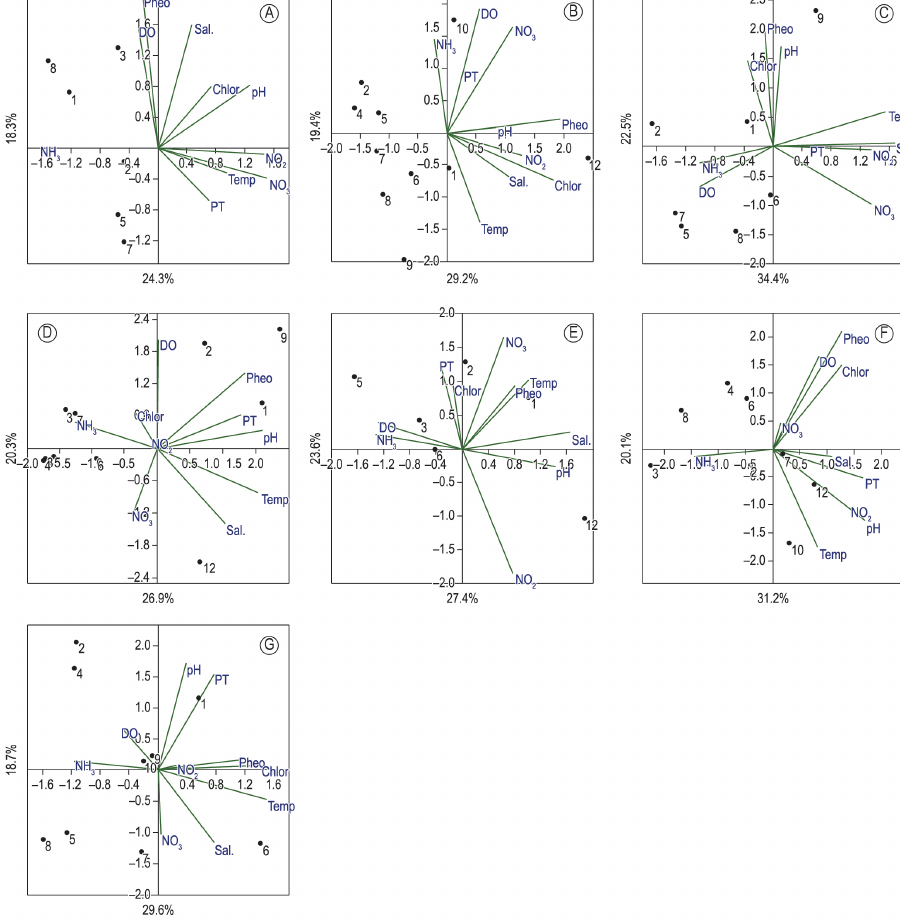
Figure 6. First two axes of the principal component analyses of limnological parameters per sampling site (A – P1, B – P2, C – P3, D – P4, E – P5, F – P6, and G – P7) and percentages of variance explained by the axes are